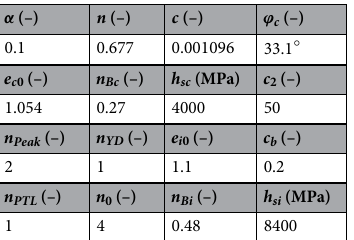
Table 6. Material parameters of Hypo+YS for KFS from 42